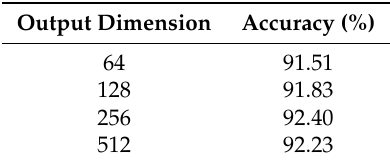
Table 5. Classification accuracies (%) under different dimensions of the output of the vision subnetwork in JFCNN.